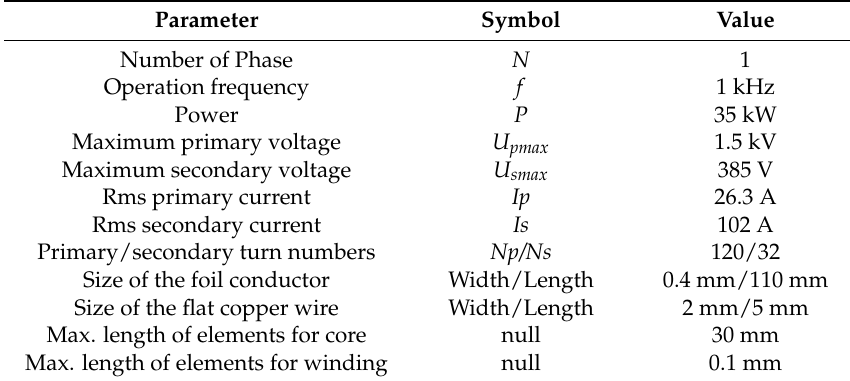
Table 1. Specifications and parameters of the 35 kW MFT.